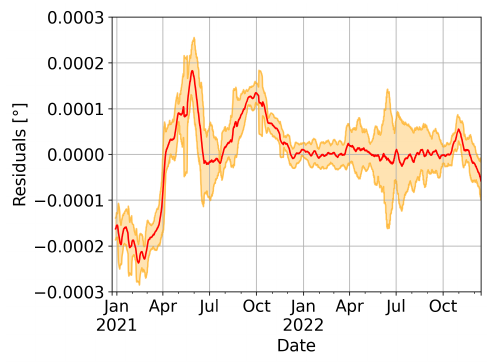
Figure 13. Autoencoder: T2 residuals.